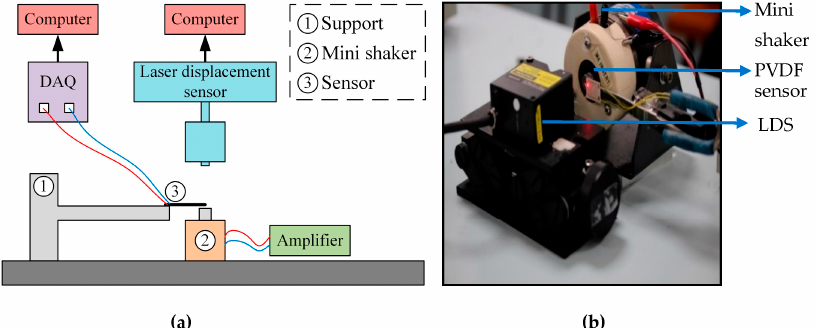
Figure 5. Experimental set-up for the vibration characterization of the sensor in cantilever configuration: ( a ) The schematic of the set-up shows the sensor attached to the support in a cantilever configuration and the corresponding equipment for the vibration testing; ( b ) A digital photo of the experimental set-up that shows the laser light from the LDS at the tip of the sensor.